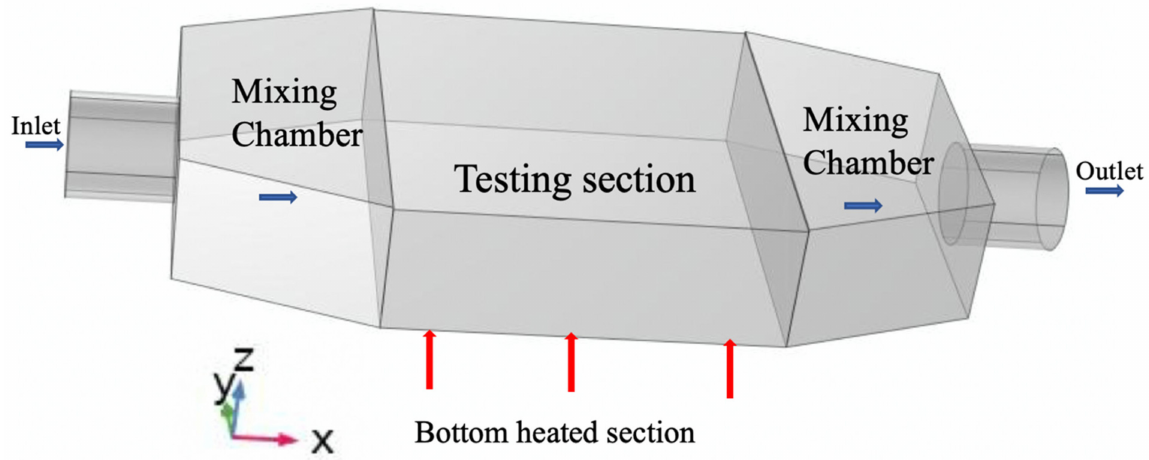
Figure 2. Boundary conditions.